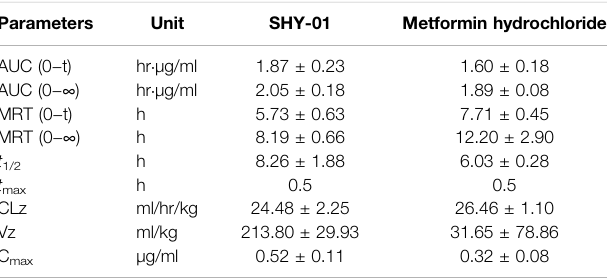
TABLE 2 | Rat brain distribution of metformin treated with metformin threonate (SHY-01) or metformin hydrochloride (50 mg/kg, i.p. ). Parameters Unit SHY-01 Metformin hydrochloride